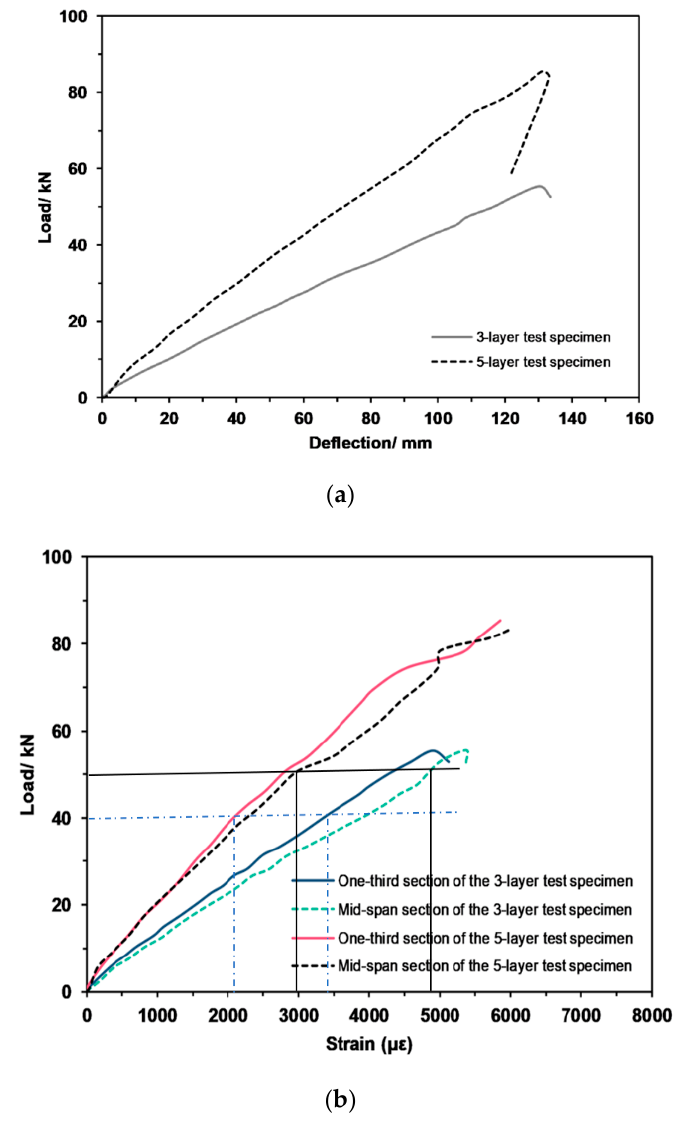
Figure 13. Effect of number of nail layers on load ‐ deflection and load–strain relationship. ( a ) Load ‐ Figure 13. E ff ect of number of nail layers on load-deflection and load-strain relationship. deflection curve; ( b ) Load–strain curve. ( a ) Load-deflection curve; ( b ) Load-strain